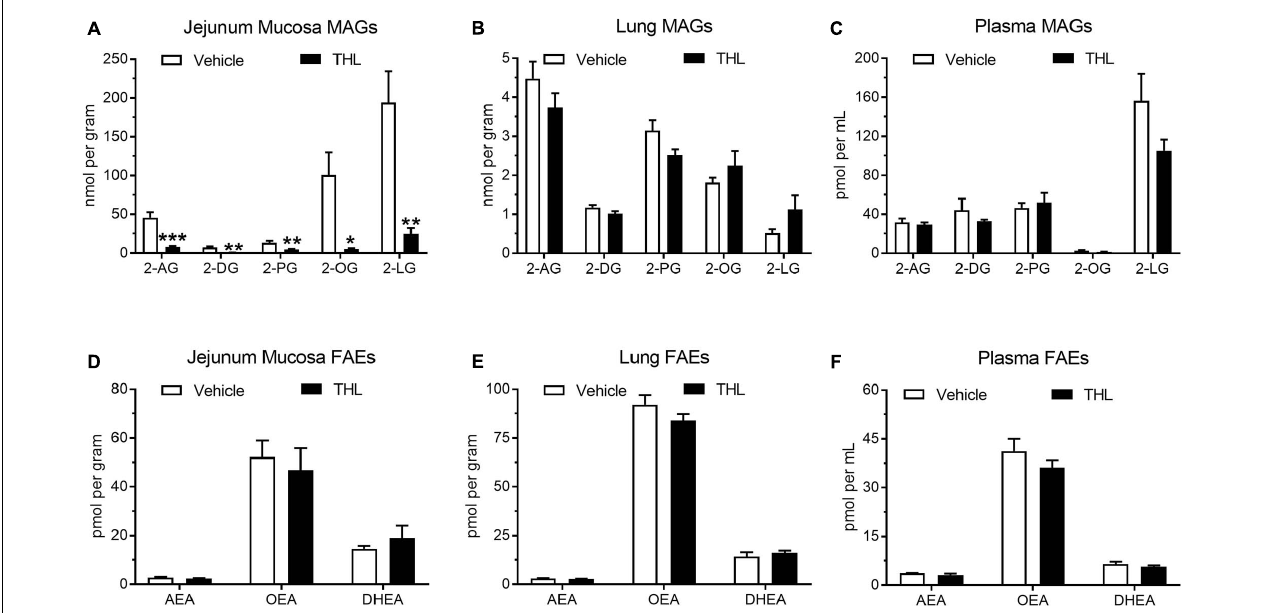
FIGURE 6 | Oral gavage of the DGL inhibitor, THL, inhibited production of MAGs in the upper small-intestinal epithelium (A) , but not in lung (B) or in circulation (C) . THL had no effect on levels of FAEs in upper small-intestinal epithelium (D) , lung (E) , and circulation (F) . *-indicates p -value < 0.05, **indicates p -value < 0.01, ***indicates p -value < 0.001, n =